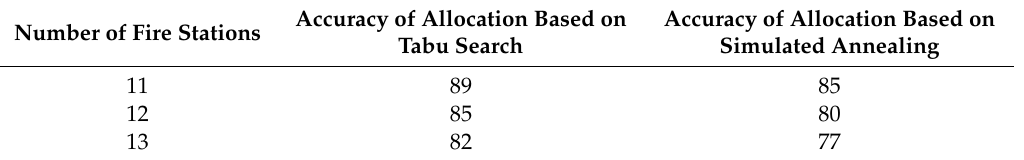
Table 5. Comparison of the accuracy of allocation results.